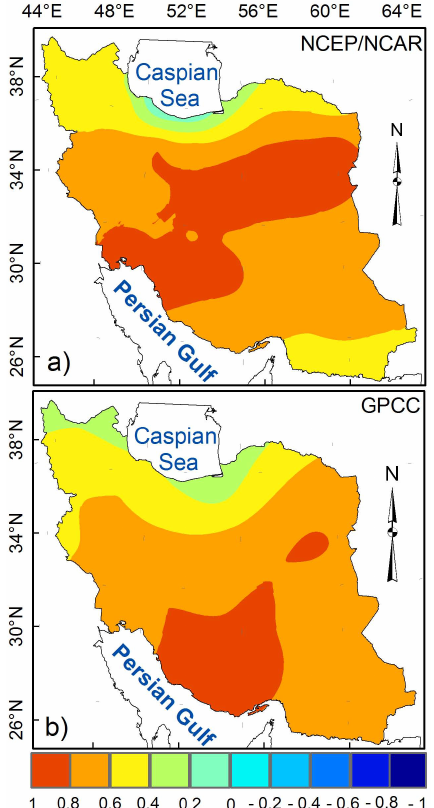
Fig. 3. Principal component analysis of the SPI field. First loading, i.e. the first spatial pattern properly normalized that represents the correlations between the corresponding PC score and the SPI time series, for: (a) NCEP/NCAR, (b)